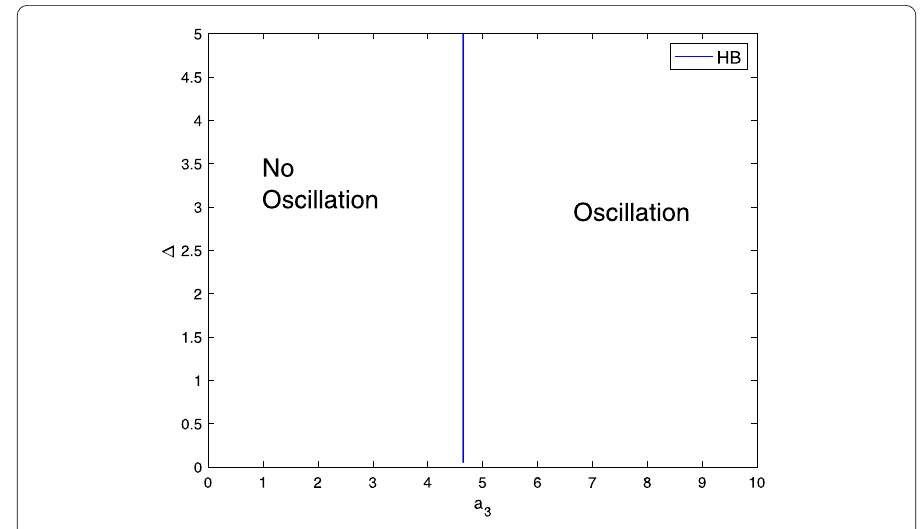
Figure 7 A two-parameter plot showing the role of a 3 and (cid:5) on generating limit cycle oscillations. Parameter values are similar to Fig. 1